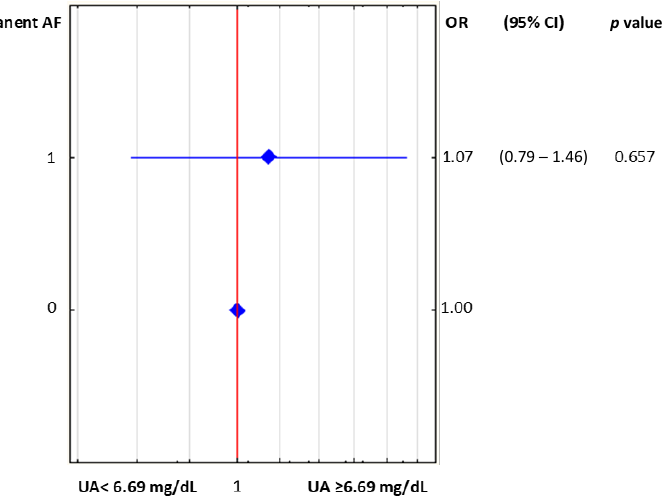
Figure 6. Results of univariate logistic regression for permanent AF and UA cutoff value (6.69 mg/dL). Abbreviations: AF, atrial fibrillation; UA, uric acid; OR, odds ratio; CI, confidence interval.